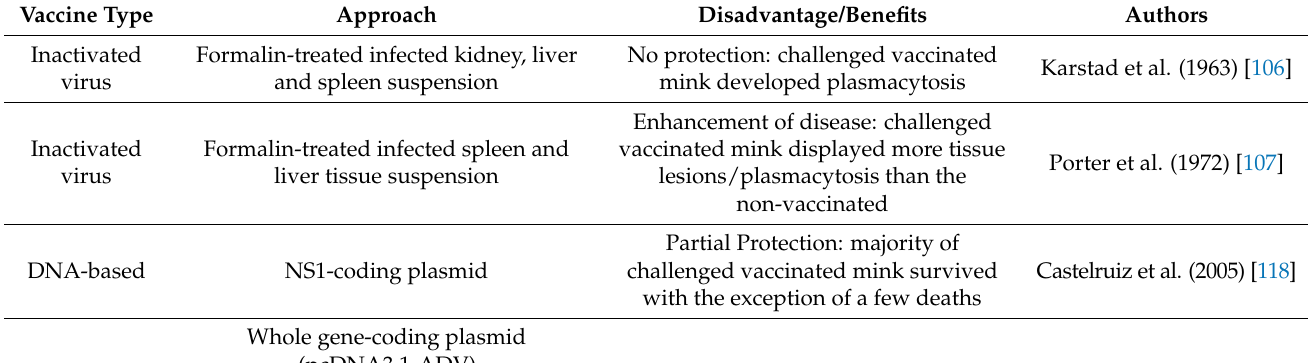
Table 2. AMDV Vaccination